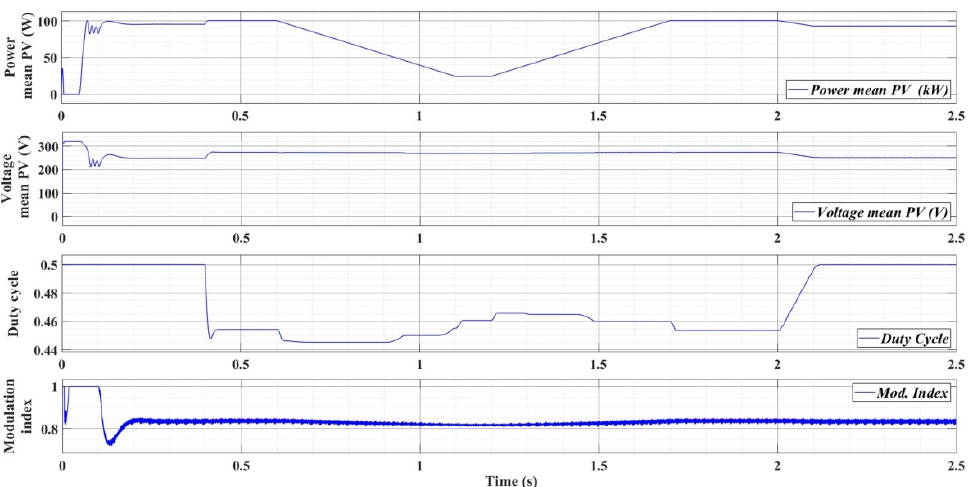
Figure 30. The time evolutions of P mean and U mean , the duty cycle of the DC-DC converter and the modulation index of the DC–AC converter (signal evolution of the type 1 PV array).